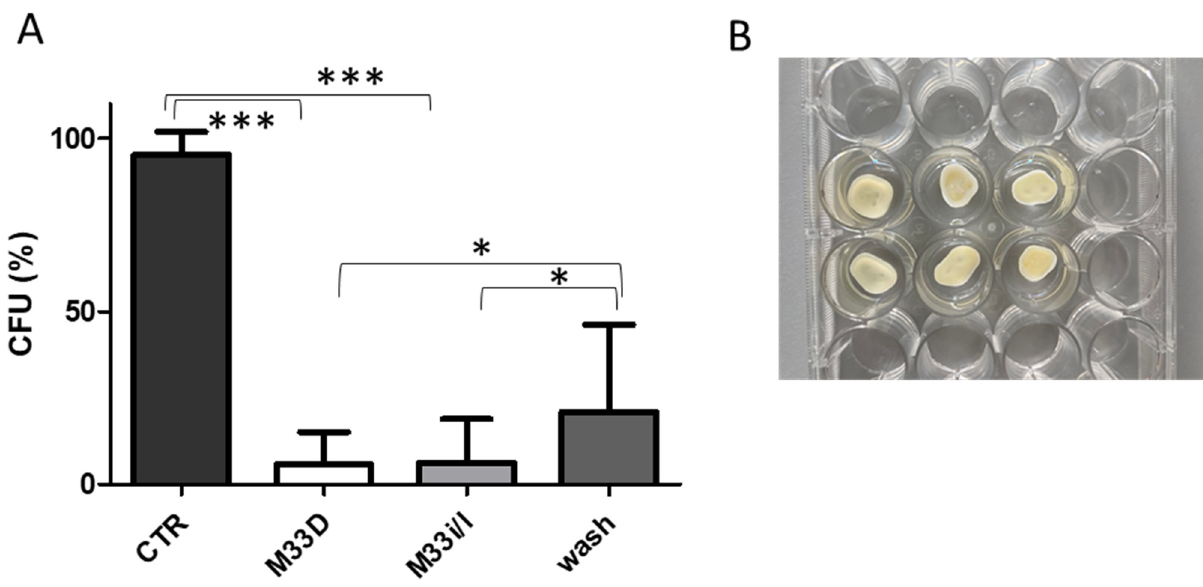
Figure 3. Inhibition of bacterial regrowth expressed in % CFU with respect to nonwashed control. ( A ) regrowth after washing dentin slices with peptides; *** p < 0.0001; * p < 0.0188 M33D; * p = 0.0423 M33i/l, CTR n = 5, M33D and M33i/l n = 20, washes n = 10; ( B ) image of dentine slices in a 24-well plate.